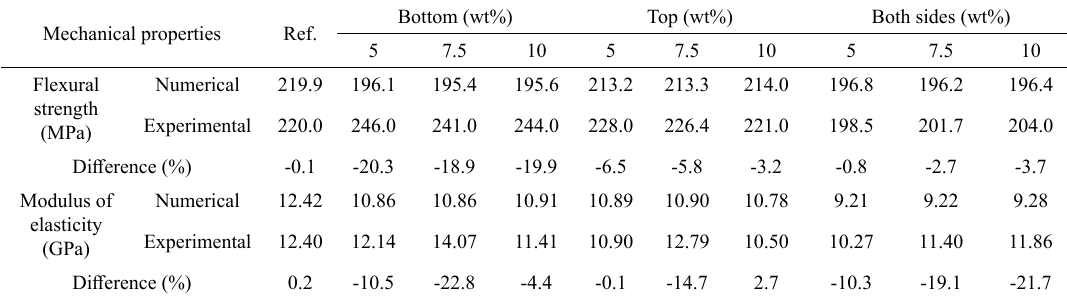
Figure 3. Interaction effect plots for mean flexural (a) strength and (b) modulus. Table 6. Numerical and experimental flexural behaviour.